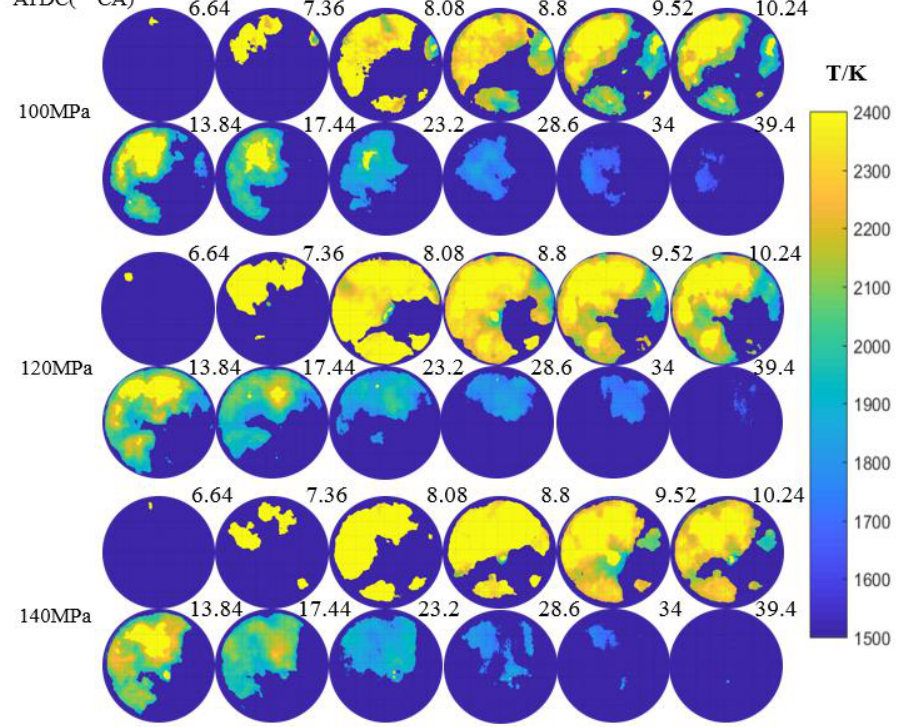
Figure 10. Spatial temperature distribution of P20 at 6-°CA BTDC injection timing.